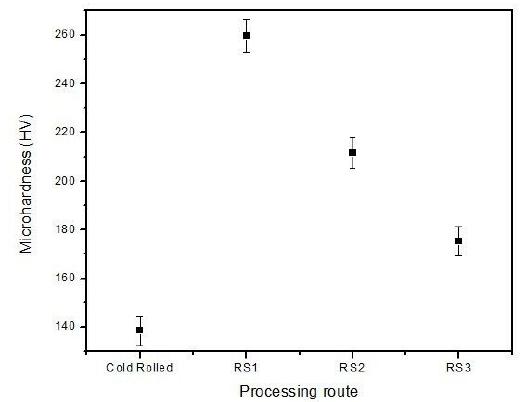
Figure 8. Microhardness (HV) of the 316L stainless steel in the cold rolled and rapid solidification conditions in regions RS1, RS2 and